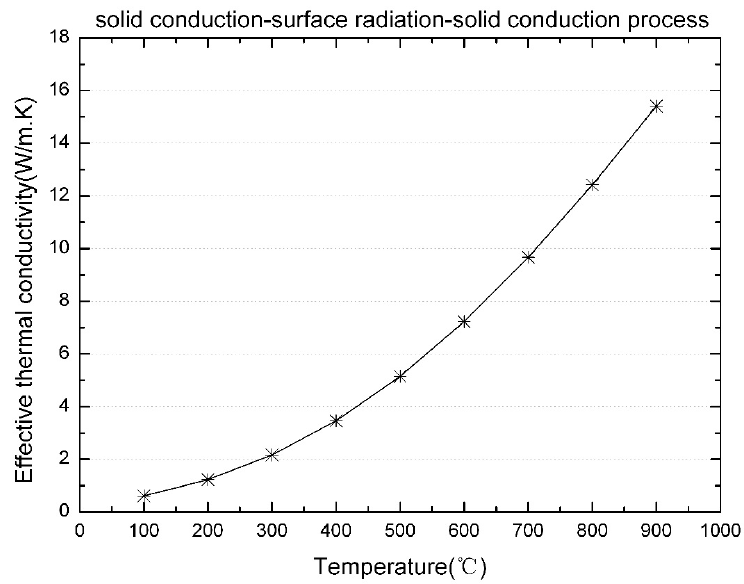
Figure 3. Effective thermal conductivity due to the solid conduction-surface radiation-solid conduction heat transfer process.